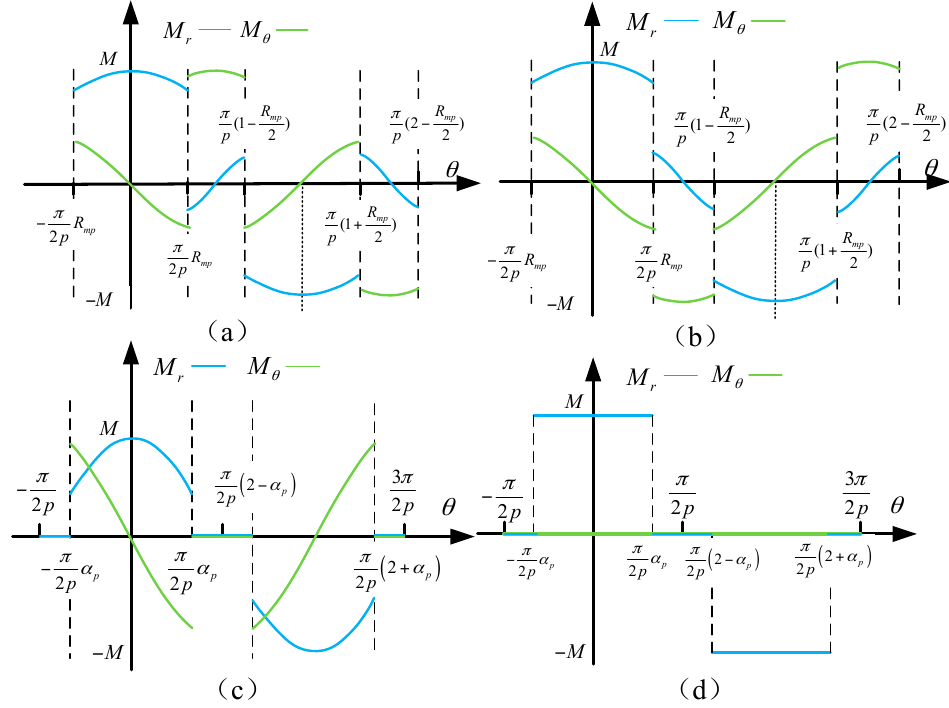
Figure 4. Waveforms of magnetization components M r and M θ . ( a ) Halbach magnetized outer rotor. ( b ) Halbach magnetized inner rotor. ( c ) Parallel magnetized inner rotor. ( d ) Radial magnetized inner rotor.